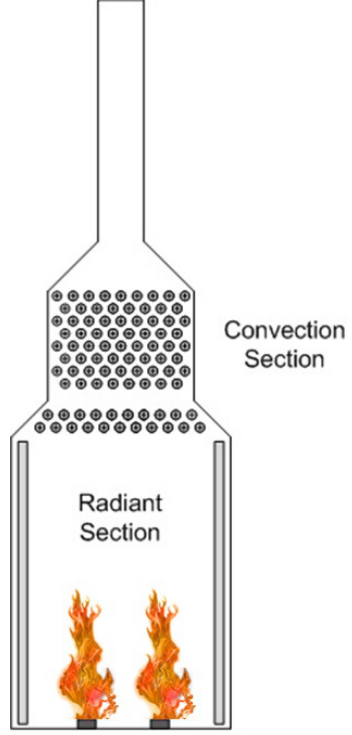
Figure 1. Typical fired heated furnace.